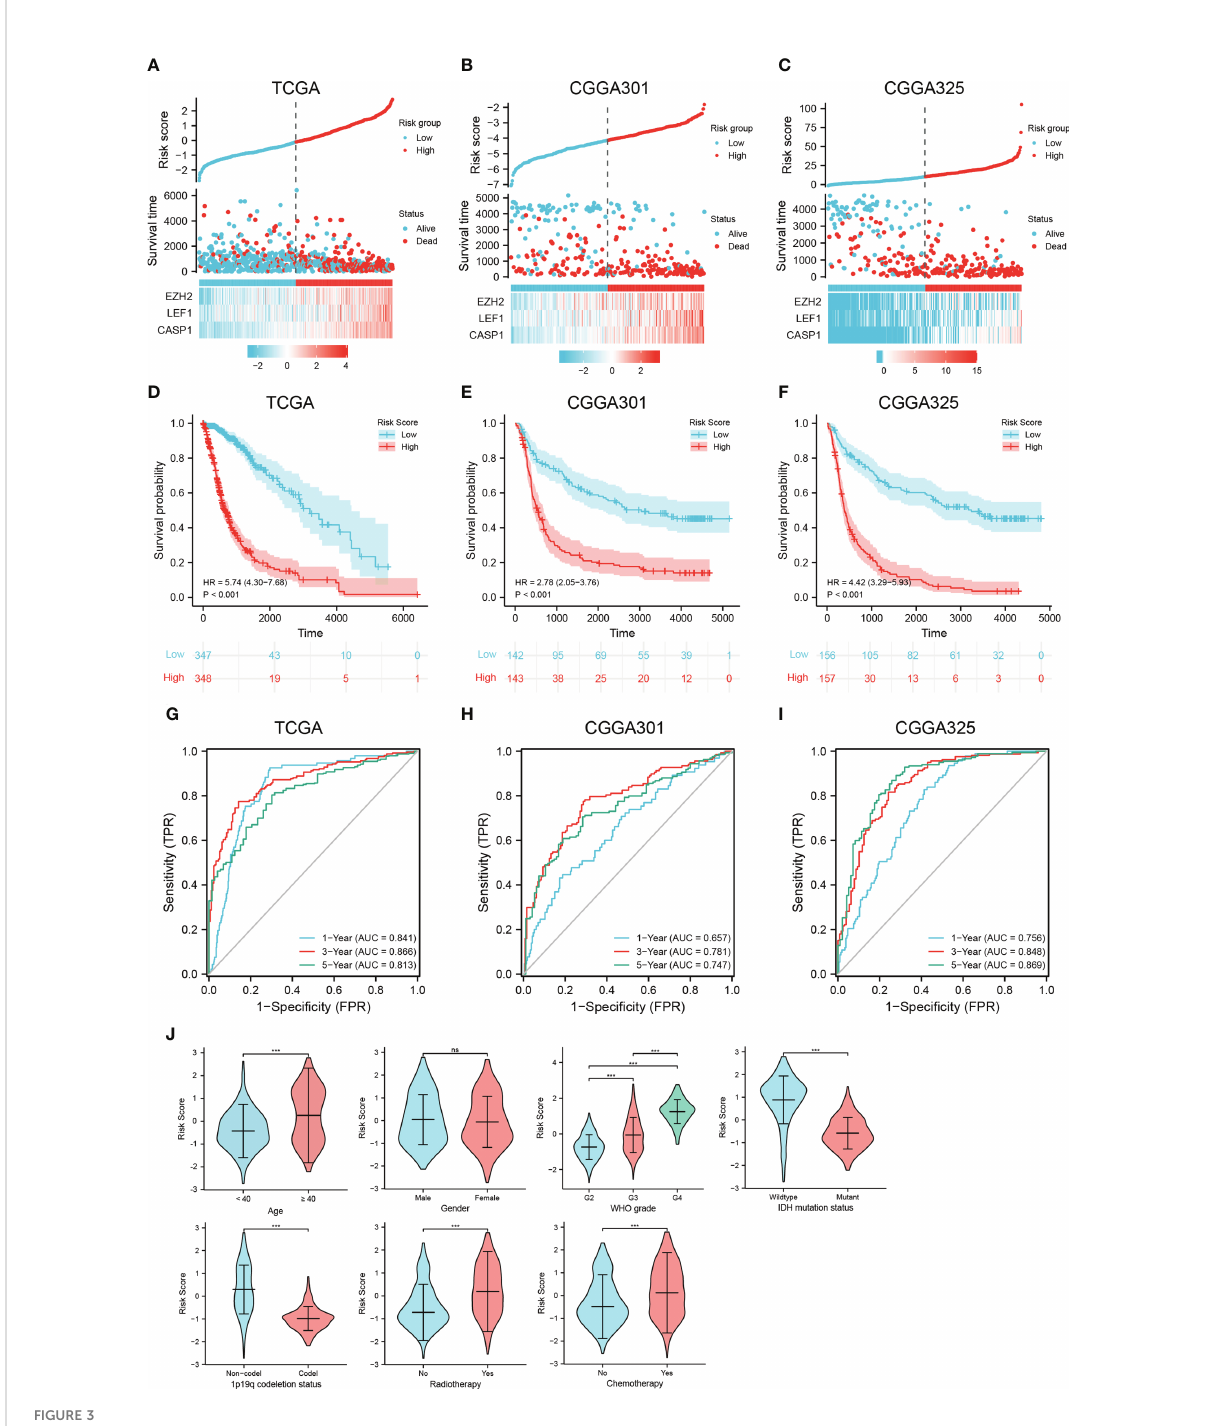
FIGURE 3 Construction and validation of a necroptosis-related risk model and its association with clinicopathologic features. (A – C) The risk score, survival distributions, and expression heatmaps of EZH2 , LEF1 , and CASP1 in the TCGA and CGGA cohorts. (D – F) Kaplan-Meier survival analysis based on the necroptosis-related risk model in the TCGA and CGGA cohorts. (G – I) ROC curves predicting 1-, 3-, 5-year OS of glioma patients in the TCGA and CGGA cohorts. (J) The associations between the necroptosis-related risk model and clinicopathological features (*** p < 0.001; ns, not signi fi